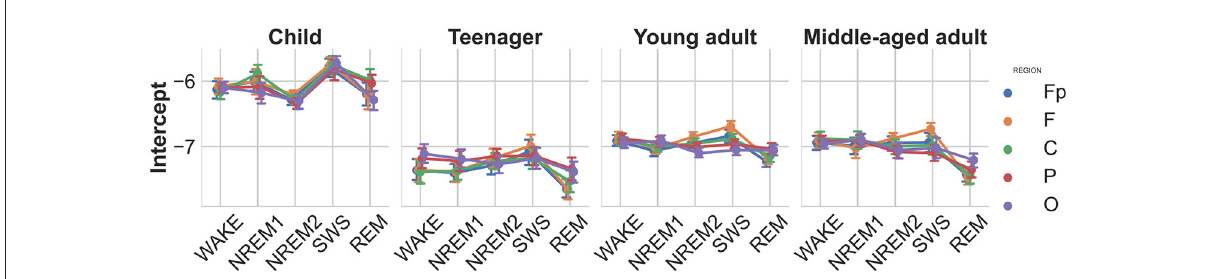
FIGURE3 Modified spectral intercepts as functions of sleep stage, brain region, and age group. Note the particularly high intercepts in children, indicating high overall EEG amplitude values. Furthermore, the modified intercepts of SWS stage, especially the ones measured over the frontopolar recording regions, exceed other stages and regions. Vertical bars denote 95% confidence